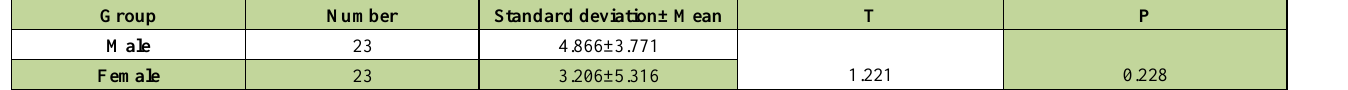
Table 6. Comparison of mean difference of index plaque of the second period between the two genders.